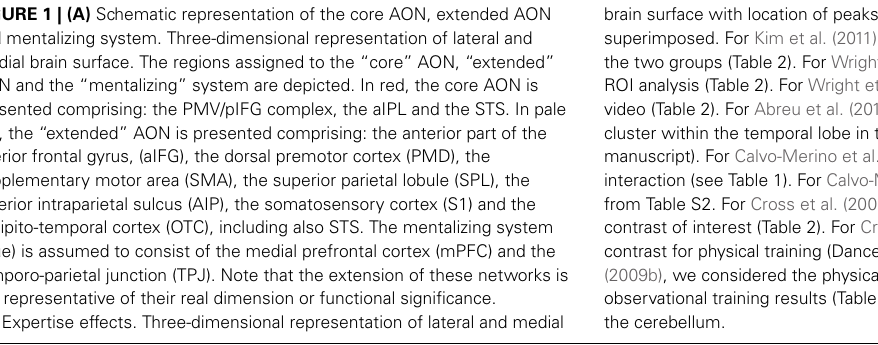
FIGURE 1 | (A) Schematic representation of the core AON, extended AON and mentalizing system. Three-dimensional representation of lateral and medial brain surface. The regions assigned to the “core” AON, “extended” AON and the “mentalizing” system are depicted. In red, the core AON is presented comprising: the PMV/pIFG complex, the aIPL and the STS. In pale red, the “extended” AON is presented comprising: the anterior part of the inferior frontal gyrus, (aIFG), the dorsal premotor cortex (PMD), the supplementary motor area (SMA), the superior parietal lobule (SPL), the anterior intraparietal sulcus (AIP), the somatosensory cortex (S1) and the occipito-temporal cortex (OTC), including also STS. The mentalizing system (blue) is assumed to consist of the medial prefrontal cortex (mPFC) and the temporo-parietal junction (TPJ). Note that the extension of these networks is not representative of their real dimension or functional significance. (B) Expertise effects. Three-dimensional representation of lateral and medial